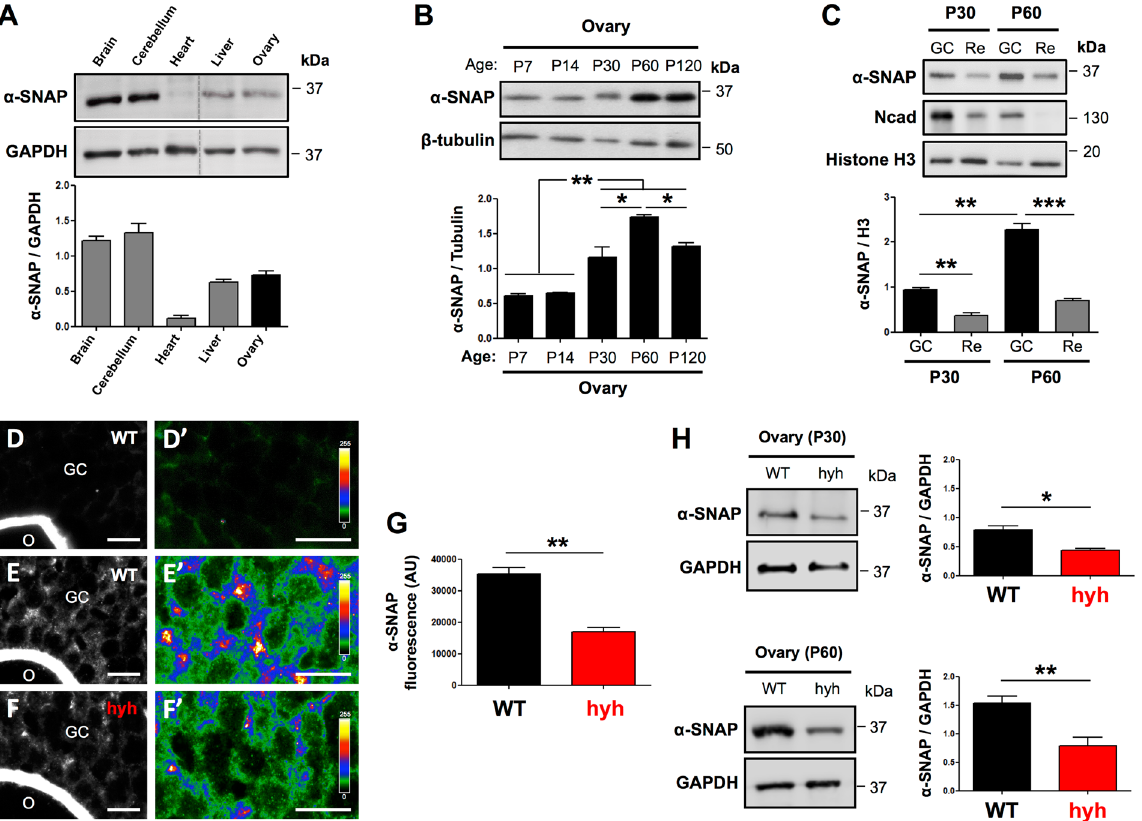
Figure 1. α -SNAP expression in mouse ovarian tissue and granulosa cells (GCs) of wild type (WT) and α -SNAP mutant (hyh) females. ( A ) Western blot analysis of α -SNAP in postpubertal (postnatal day 60; P60) WT female mouse tissue extracts. GAPDH levels serve as loading control. Cropped blots (dotted lines) are displayed. Full-length blots including other tissue extracts are included in the Supplementary Figures file online (see Supplementary Figure S1). ( B ) Western blot analysis of α -SNAP in prepubertal (P7 and P14), peripubertal (P30), and postpubertal (P60 and P120) ovary extracts. β -tubulin levels serve as loading control. ( C ) Western blot analysis of α -SNAP in purified GCs and ovary remnants depleted of GCs (Re) at P30 and P60. N-cadherin (Ncad) was used as a marker of GC enrichment (see Supplementary Information) and Histone H3 was used as loading control. ( A – C) Bars represent mean ± SEM of densitometric analyses (n = 3 or 4 independent experiments). ( D–F ) α -SNAP immunolabeling in P60 WT ( E ) and mutant hyh ( F ) ovarian follicles. Omission of the primary antibody was used as a negative control ( D ). Note the expression of α -SNAP in GCs. The expression of α -SNAP in the oocyte ( O ) cannot be established because of a non-specific fluorescent signal detected in the oocyte-zona pellucida region. ( D ) Scale bars, 10 μ m. ( D’–F’ ) Magnifications of GC regions in ovarian follicles. Images were pseudocolored using the lookup table shown at the right of the figures to highlight the differences in fluorescence intensity between WT ( E’ ) and mutant hyh ( F’ ) samples. Scale bars, 10 μ m. ( G ) Quantification of α -SNAP immunofluorescence intensity in WT (black bar) and hyh (red bar) GCs. Bars represent mean ± SEM of 4 independent experiments. ( H ) Western blot images and densitometric analysis of α -SNAP in WT and hyh ovaries at P30 and P60. GAPDH was used as loading control. Note the hypomorphism of α -SNAP in hyh samples at both developmental stages. Bars represent mean ± SEM of densitometric analyses (n = 3 independent experiments). * p < 0.05; ** p < 0.01; *** p < 0.001 (ANOVA with Tukey’s post hoc test or Student’s